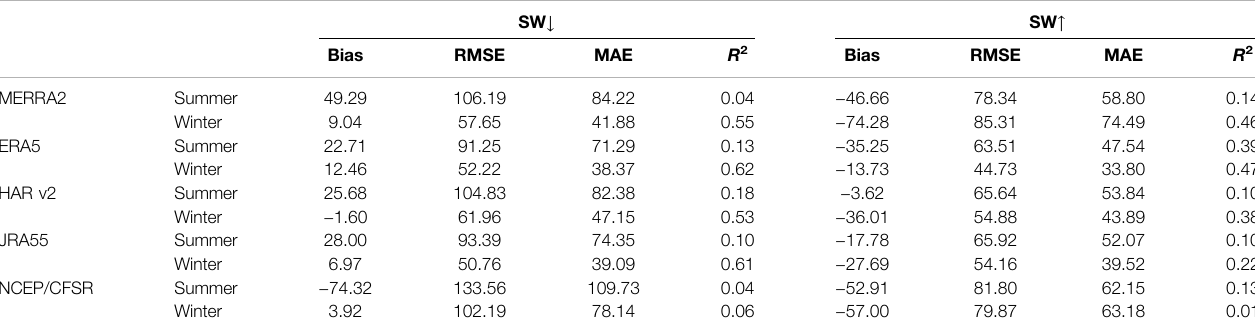
TABLE 5 | Results of the fi ve reanalysis datasets for shortwave radiation evaluated in summer and